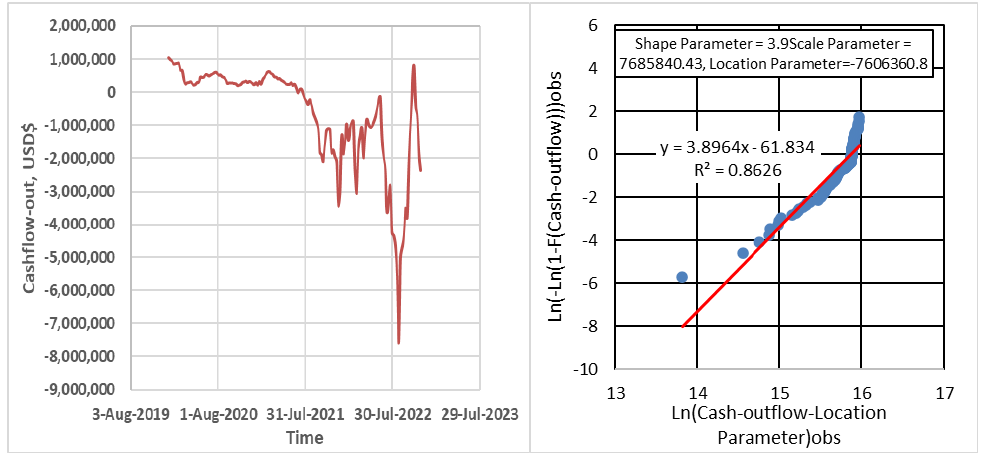
Figure 5. Cash-flow peaks ( left ) and Weibull descriptors of cash flow ( right ).